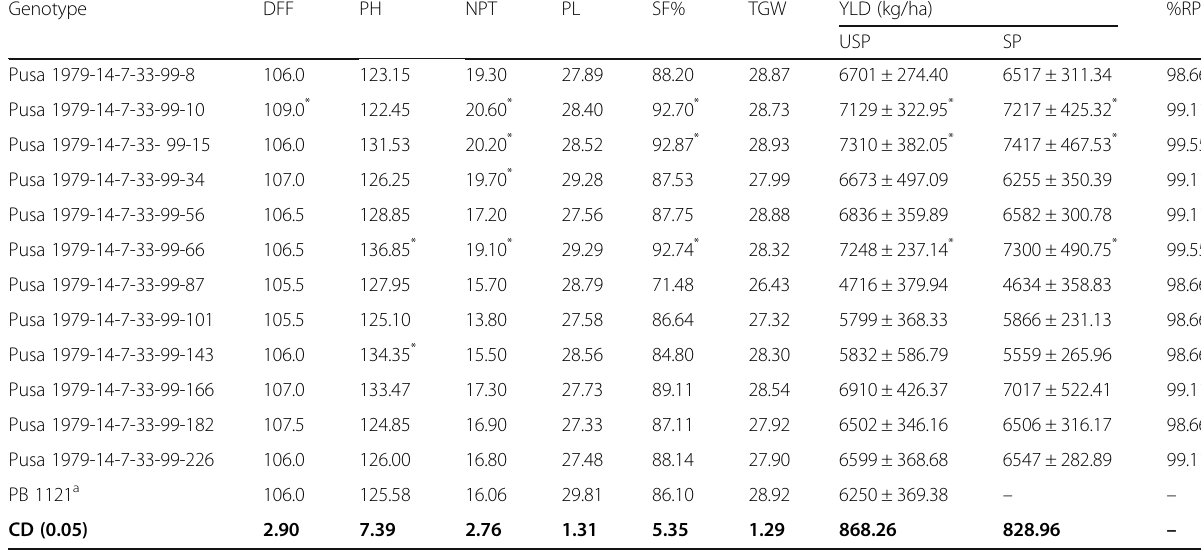
Table 5 Agronomic performance of PB 1121 HT-NILs in comparison with the recurrent parent PB 1121 Genotype